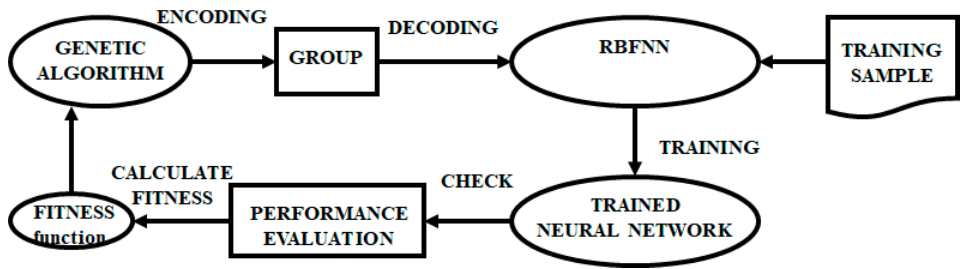
Figure 8. Working of genetic assisted RBFNN.